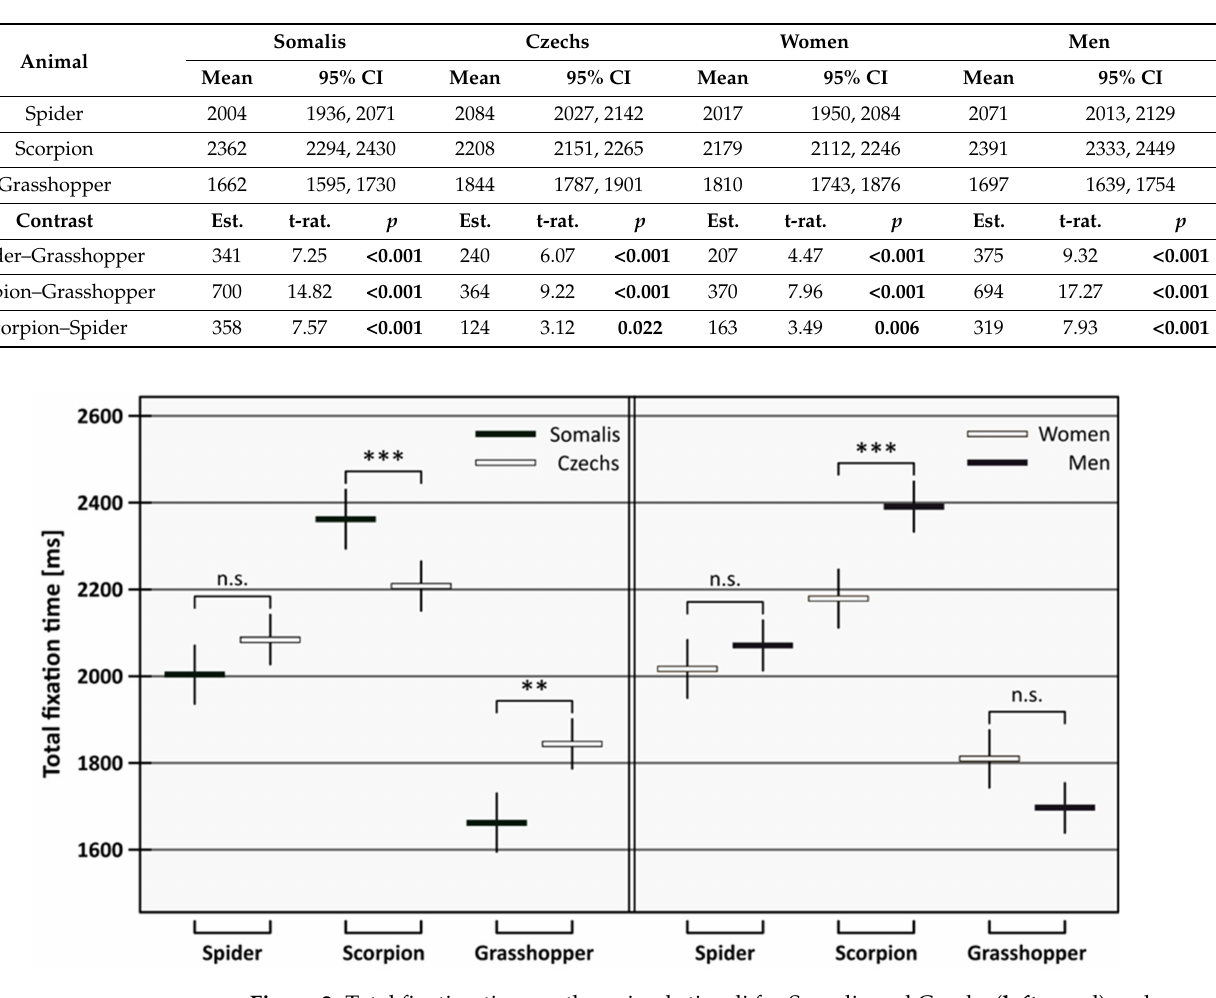
Table 1. Results of the linear mixed effect model for the total fixation time. Upper part—the estimated means and 95% confidence intervals (in milliseconds) for each stimulus (animal) within both nationalities and genders. Lower part—comparison of animal factor levels for both nationalities and genders; Est.—estimated difference; t-rat.—t-ratio; p -values < 0.05 are in bold.